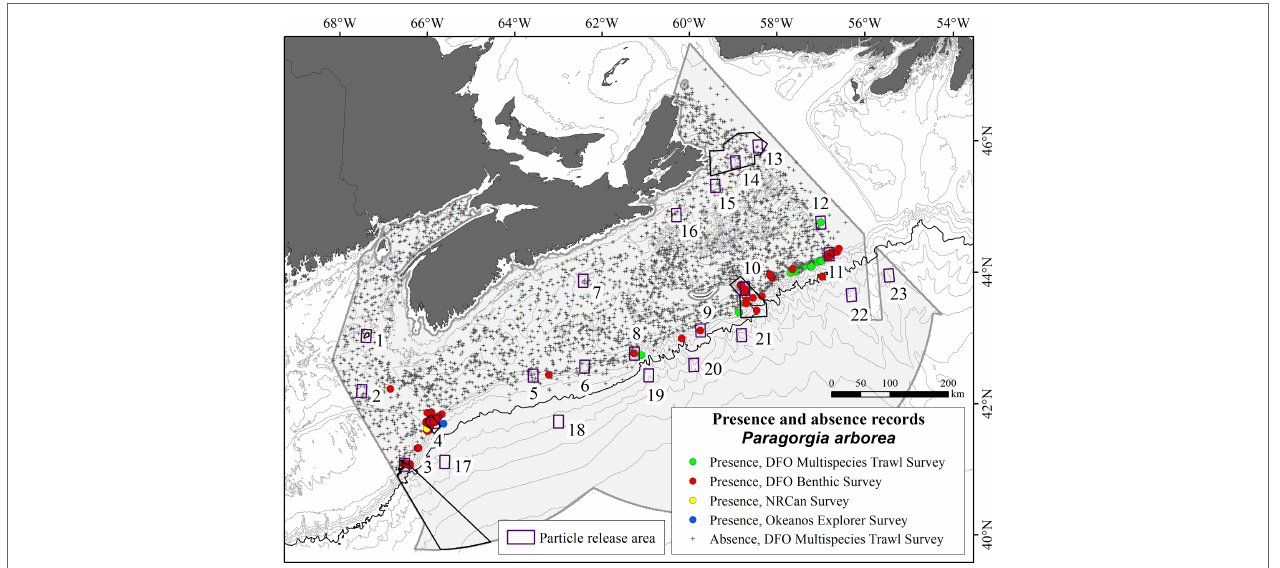
FIGURE 3 | Map of the study area showing the distribution of confirmed records of Paragorgia arborea presence and absence, and the locations of the source boxes used in LPT modeling (numbered). Bathymetric contours are shown at 50, 100, 200, and 500 m, and at 500 m below, with the 2000 m contour emphasized. The six conservation areas within the offshore extent of the study area are shown in black outline (see Figure 2 for place